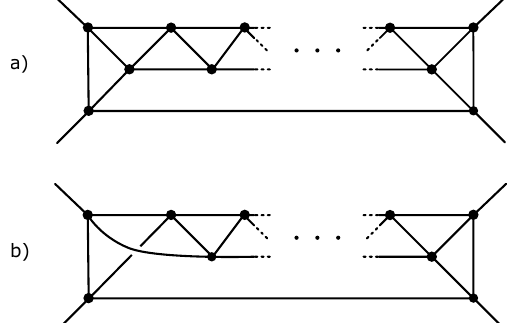
Figure 3: The planar cross and the non-planar cross (open envelope) graphs. Each of the diagrams is the first one in an infinite chain of diagrams, see figure 4, that generates the Landau curves on the physical sheet, in the region 16 m 2 ≤ s , t < 36 m 2 .